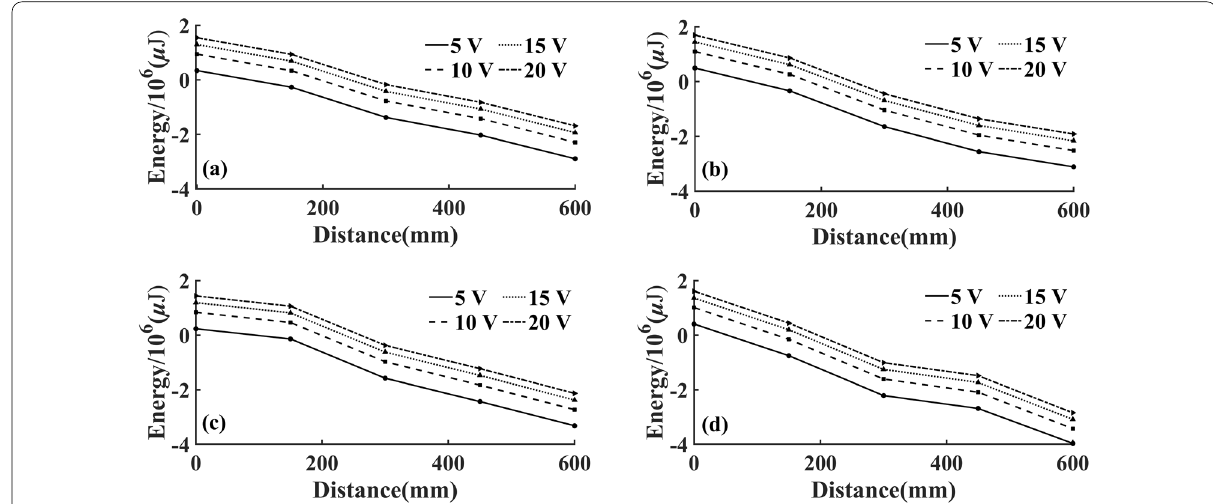
Fig. 5 Energy attenuation curve of AE surface transverse wave